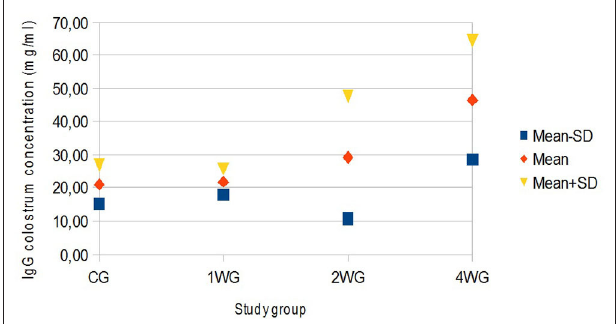
FIGURE 1 | Variability of colostrum IgG concentration depending on study group. Results are presented as mean ± SD. CG, control group; 1WG, one-week group; 2WG, two-week group; 4WG, four-week group. Each study group enrolled 5 bitches.